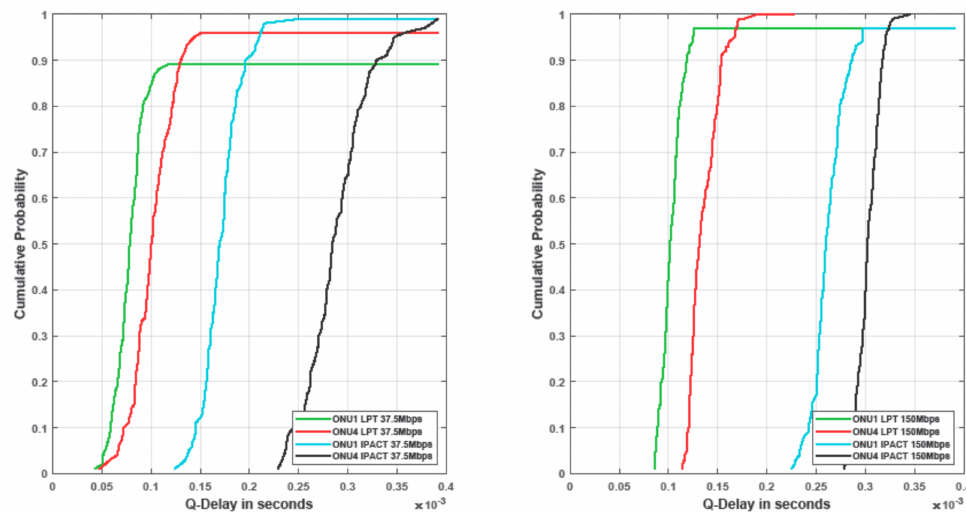
Figure 11. CDF of the queue delay for ONU 1 and ONU 4 under the IPACT and LPT algorithms for LTT = 10 µ s at offered loads of 37.5 Mbps ( left ) and 150 Mbps ( right